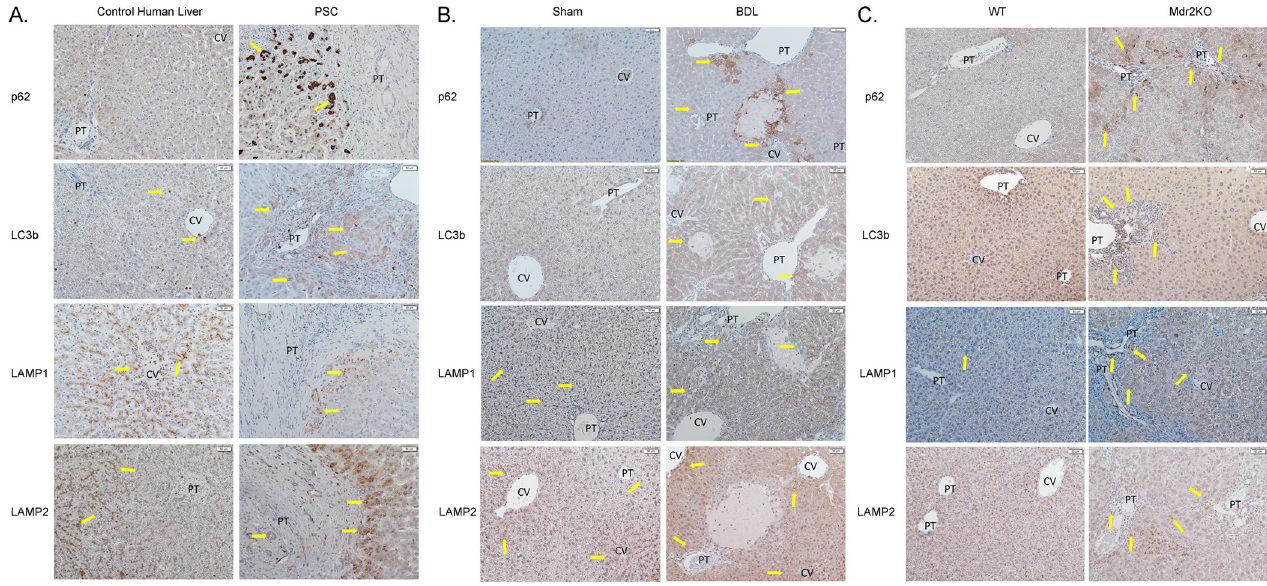
Fig 3. Increased accumulation of p62, LC3b, LAMP1 and LAMP2 in PSC and BDL mice is located primarily in parenchymal cells that surround the portal triad. Tissue sections from normal human liver, PSC, sham and BDL mice were examined for p62, LC3b, LAMP1 and LAMP2 expression. A . Human control and PSC. B . Sham and BDL. N = 3-5/group, 200X, CV-central vein, PT-portal triad. Arrows indicate increased staining. C . 10-week old WT and Mdr2 KO (200X). N = 3-5/group, 200X, CV-central vein, PT-portal triad. Arrows indicate increased staining.